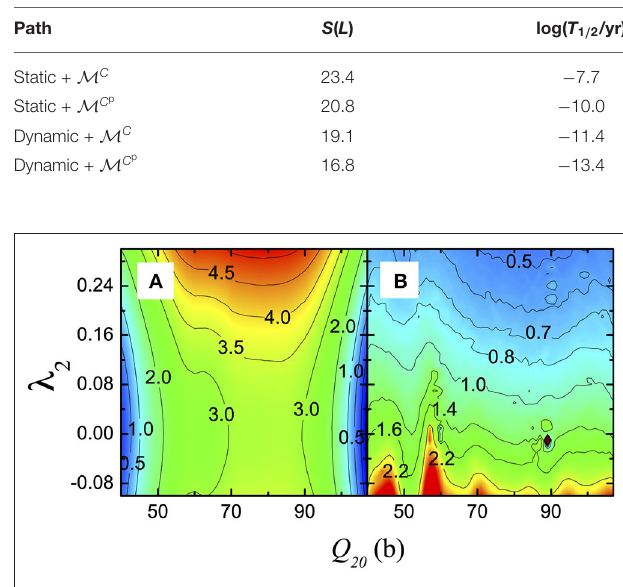
FIGURE 6 | Projections of (A) potential energy (in MeV) after subtracting the M C 1 / 3 (in h 2 MeV − 1 /1,000). Both are calculated ground state value, and (B) | | ¯ for 264 Fm in the three-dimensional space of ( Q 20 , Q 22 , λ 2 ) and then projected on the Q 22 0 plane. The figure is modified from Sadhukhan et al. =